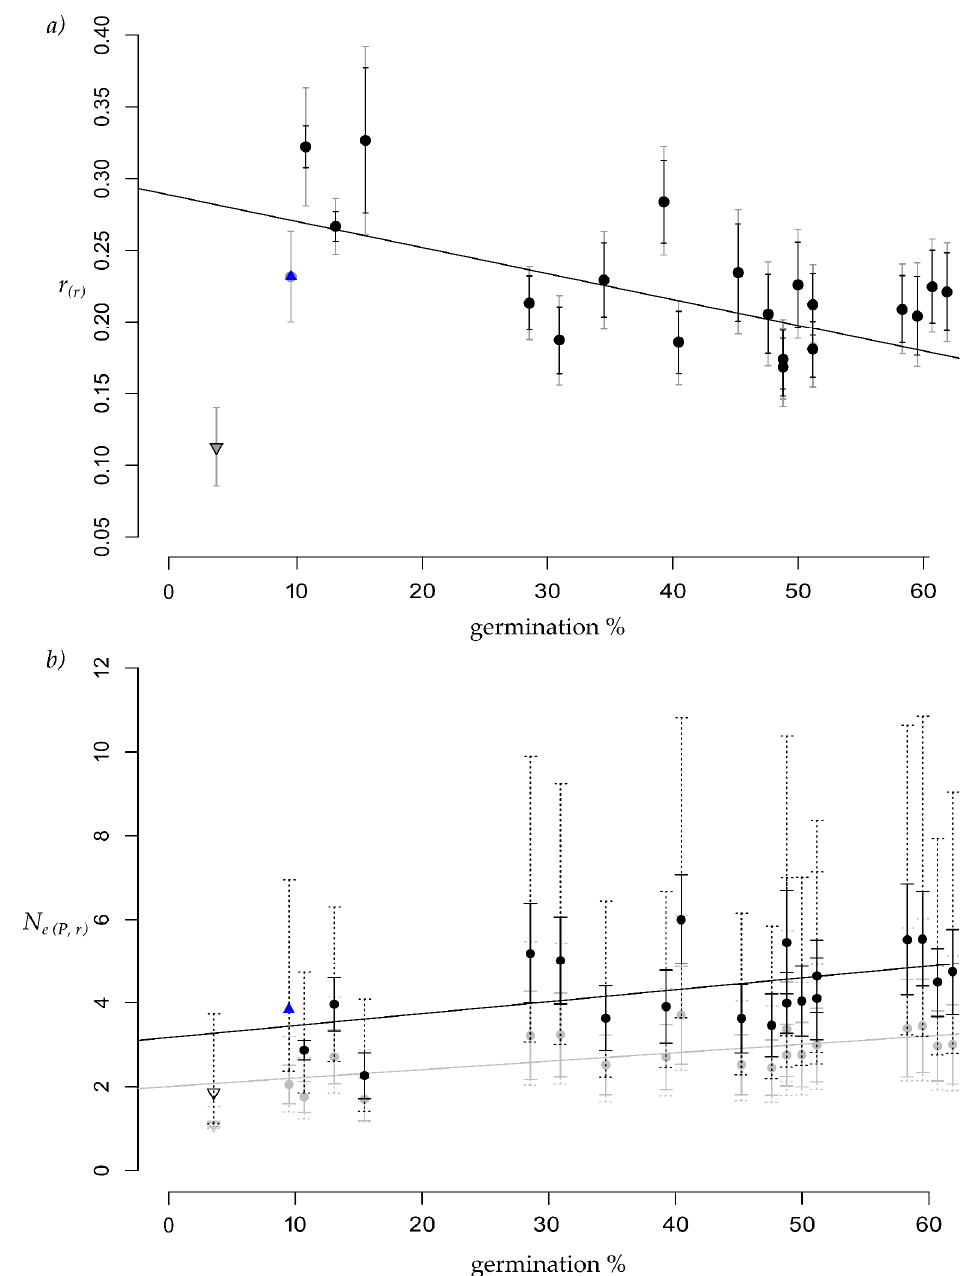
Figure 2. Scatter plot of mean seed germination percentage (x-axis) in 21 half-sib families plotted against the ( a ) rarefied mean within half-sib family relatedness ( r (r) ) or ( b ) rarefied mean effective pollen population size ( N e (P; r) ) of the half-sib families. The line represents the corresponding linear regression trendline, excluding family 1 (downward triangle) due to very limited sample size. Grey symbols and lines correspond to rarefaction with replacement, black indicates rarefied results without replacement. ( a ) adjusted R 2 = 0.33, p = 0.005; ( b ) with replacement adjusted R 2 = 0.37, p = 0.003, without replacement adjusted R 2 = 0.21, p = 0.02. Whiskers represented by solid lines in ( a ) and ( b ) show the standard deviation of the mean from the rarefaction resampling, whiskers represented by doted lines in ( b ) shown the mean confidence interval. Indicated by an upward triangle is the unrarefied value for family 13, because resampling in this family was impossible for rarefaction without replacement.